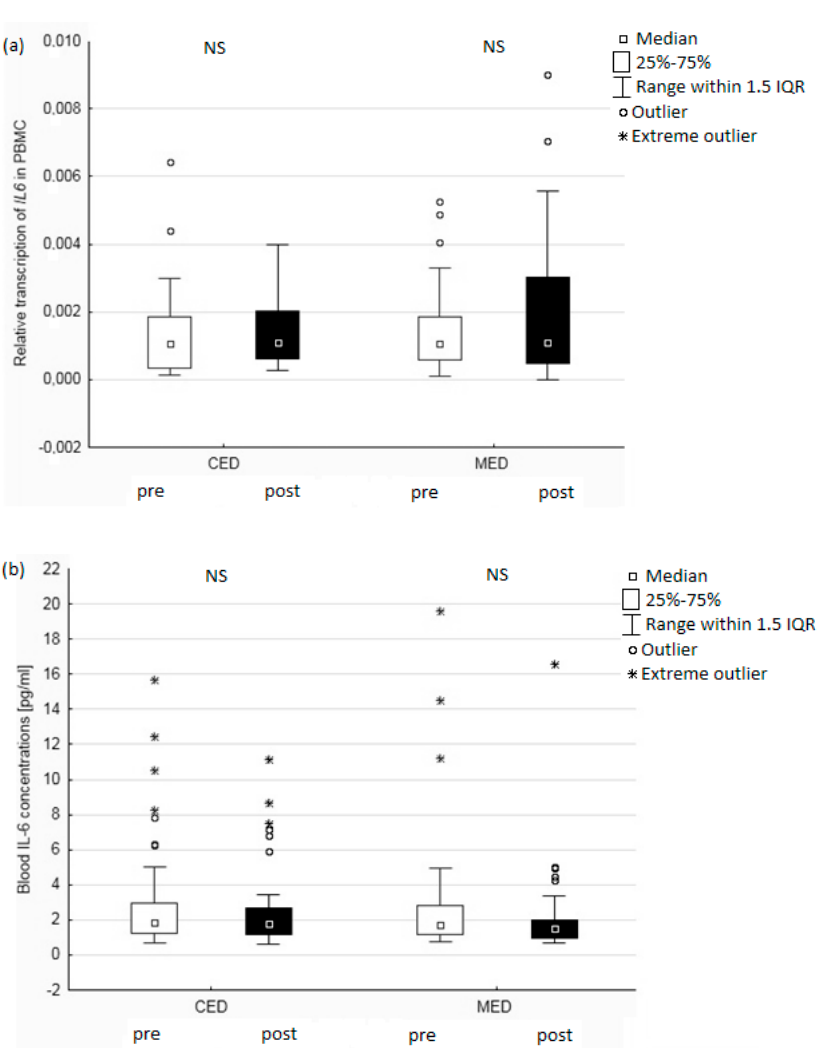
Figure 3. The mRNA levels of IL6 expression in PBMCs ( a ) and blood IL6 concentrations ( b ) pre and post intervention among 95 postmenopausal women. Boxplots show median values and interquartile ranges. Circles represent outliers which extend more than 1.5 box-lengths from the edge of the box and stars represent extreme outliers which extend more than three box-lengths. The differences between the parameters before and after the dietary intervention were assessed using the Wilcoxon test. PBMC: peripheral blood mononuclear cells; CED: Central European diet; MED: Mediterranean diet; IQR: interquartile range; NS: non-significant.